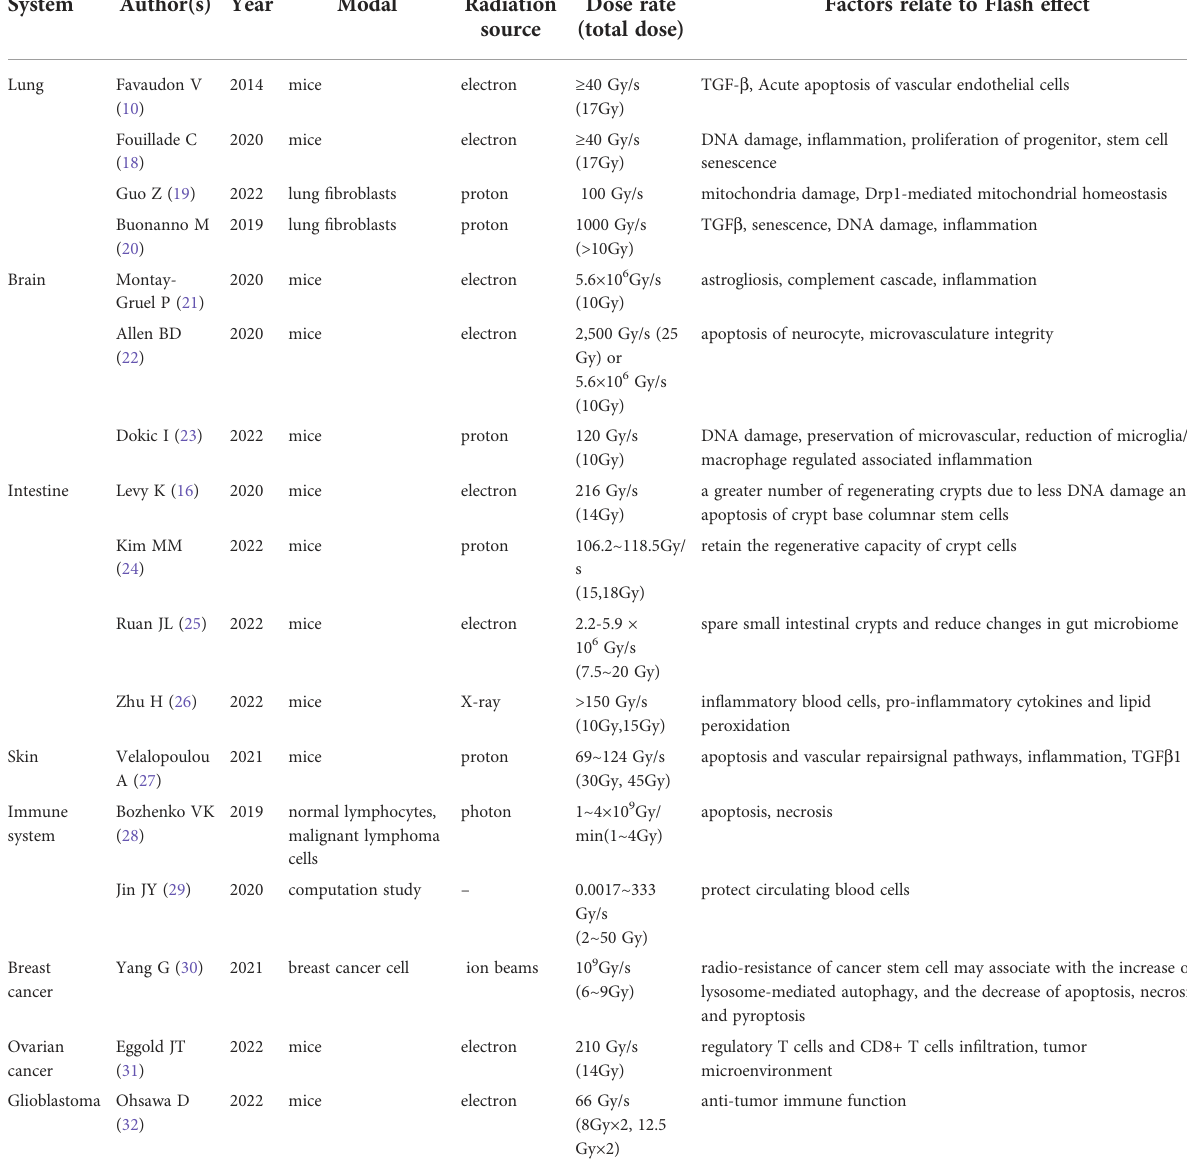
TABLE 1 Summary of published studies on FLASH effect mechanism.